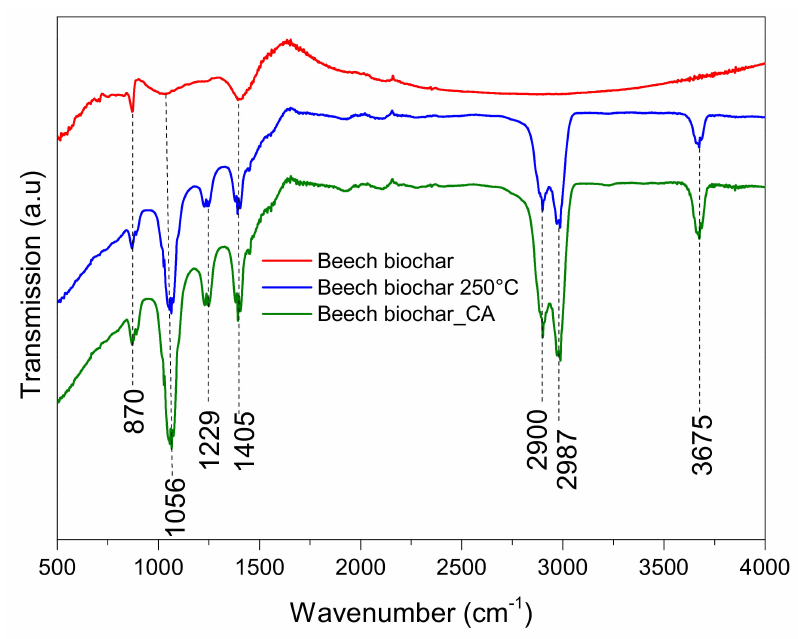
Figure 7. FTIR spectra for beech biochar before and after